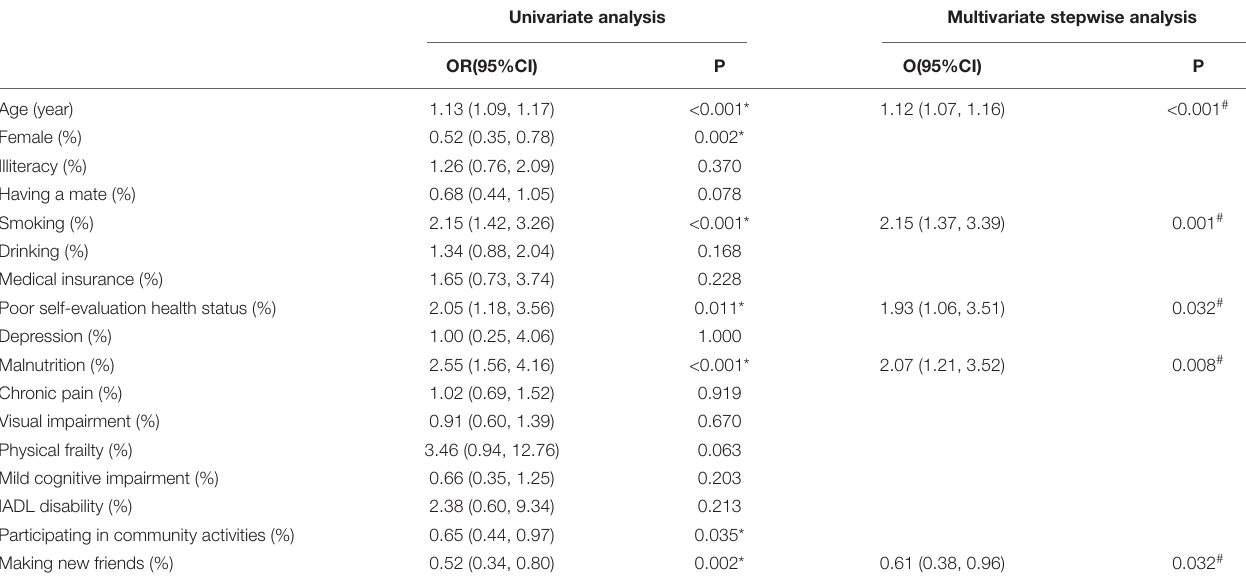
TABLE 5 | Multiple stepwise logistic regressions: factors significantly associated with transitions in cognitive frailty over 6 years. Univariate analysis Multivariate stepwise